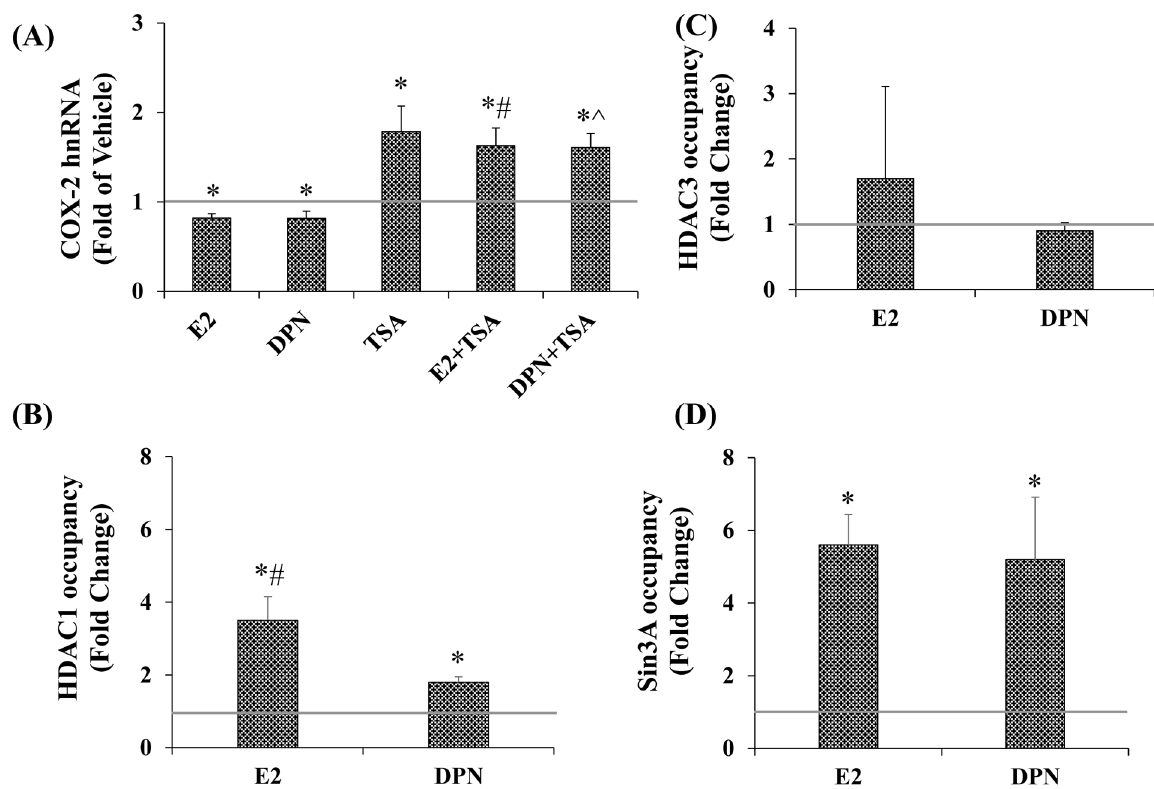
Fig 5. Deacetylation plays a role in E2 and DPN repression of basal. A, TSA increases COX-2 hnRNA. Cells were treated for 24 hrs with E2, DPN, TSA (100nm) or E2+TSA and DPN+TSA. ChIP analyses were performed for B, HDAC1 (Abcam), C, HDAC3 (Cell Signaling), and D, Sin3A (Sigma-aldrich). (n (cid:3) 3). Data represents mean ± SEM and is expressed as fold of VEH. A, ( * ) p = 0.007 for E2, p = 0.050 for DPN, p = 0.025 for TSA p = 0.013 for E2+TSA, p = 0.005 for DPN+TSA. (#) p = 0.004 E2+TSA compared to E2, (^) p = 0.003 DPN+TSA compared to DPN. B, ( * ) p = 0.008 E2, p = 0.002 DPN compared to VEH. (#) p = 0.04 E2 compared to DPN. D, ( * ) p = 0.002 E2, p = 0.048 DPN compared to